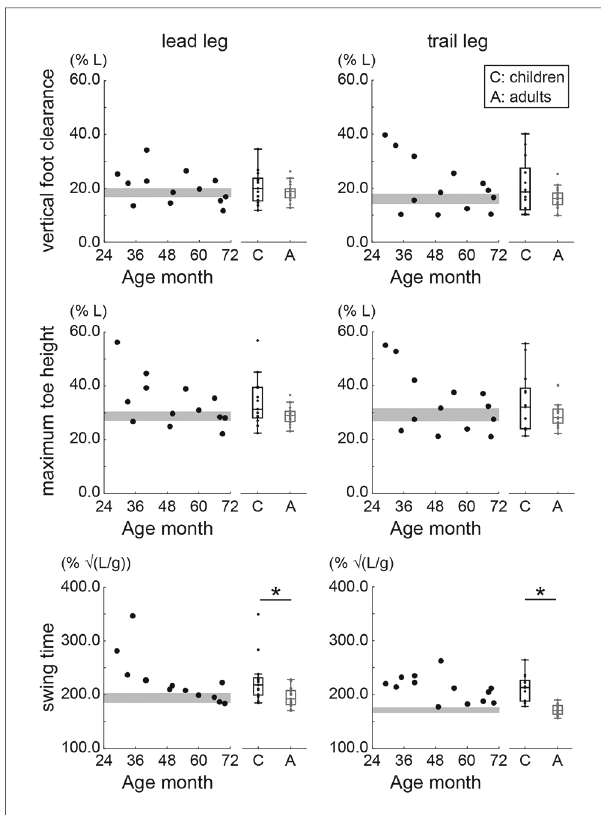
FIGURE 7 Normalized vertical foot clearance, maximum toe height, and swing time during obstacle crossing. Circles indicate the mean value of within participants. The gray area shows the 95% con fi dence interval (CI) of the mean of adults. * Indicates p